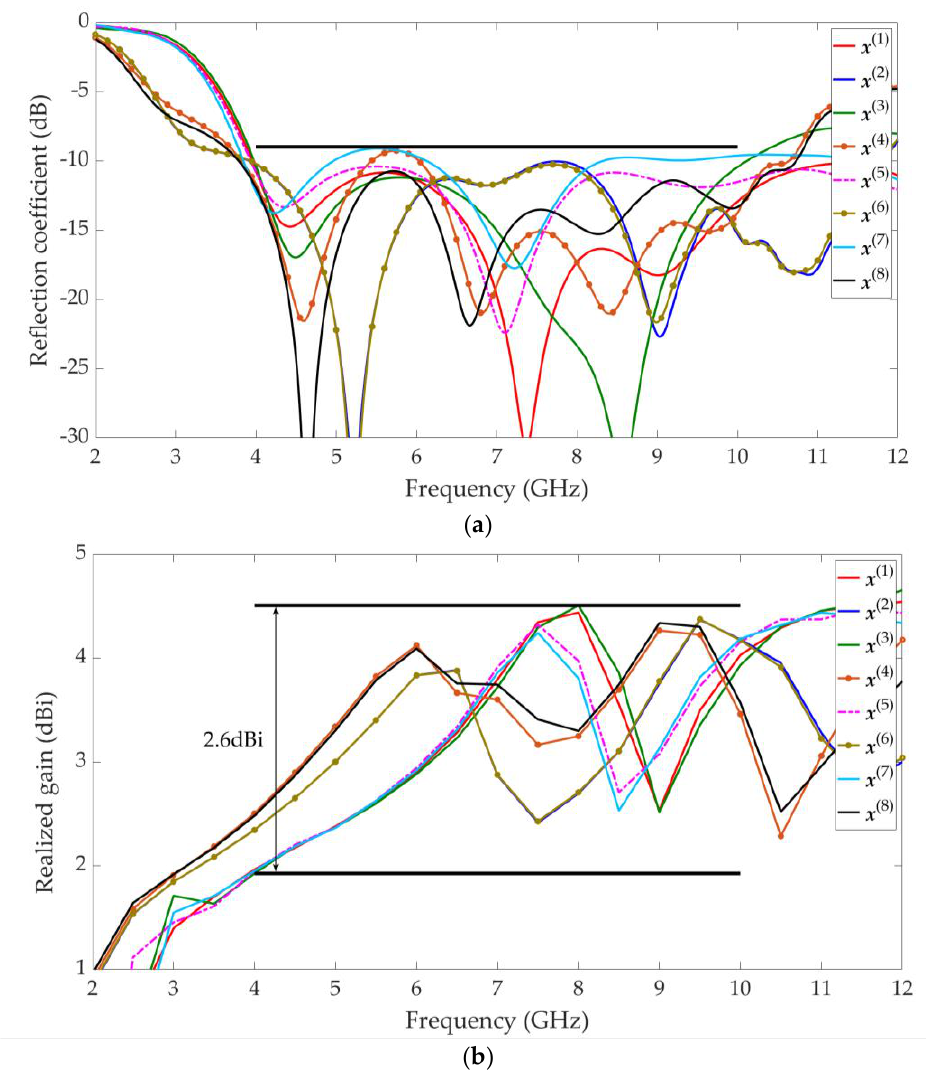
Figure 13. The selected design results ( x ( 1 ) , x ( 2 ) , ... , x ( 8 ) ref. Table 2) on the approximate Pareto set obtained by GSDP: ( a ) All S 11 ( dB ) responses are below − 9 dB between 4 GHz and 10 GHz; ( b ) All the realized gain (dBi) variationd are below 2.6 between 4 GHz and 10 GHz.